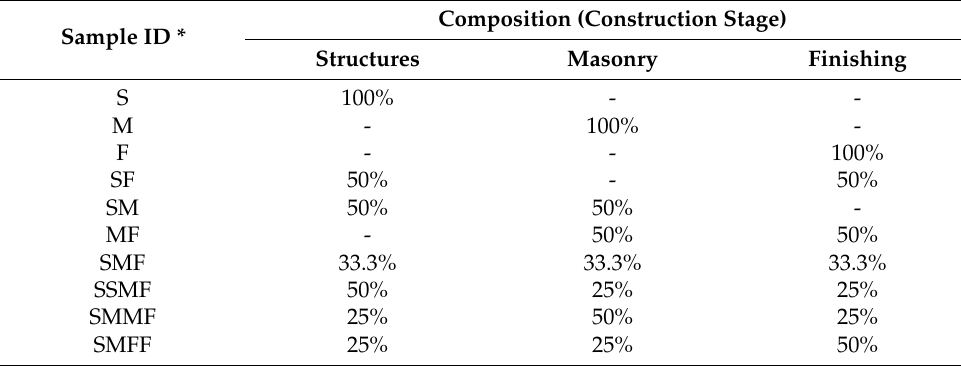
Table 1. Identification composition of the produced recycled aggregates. Sample ID *